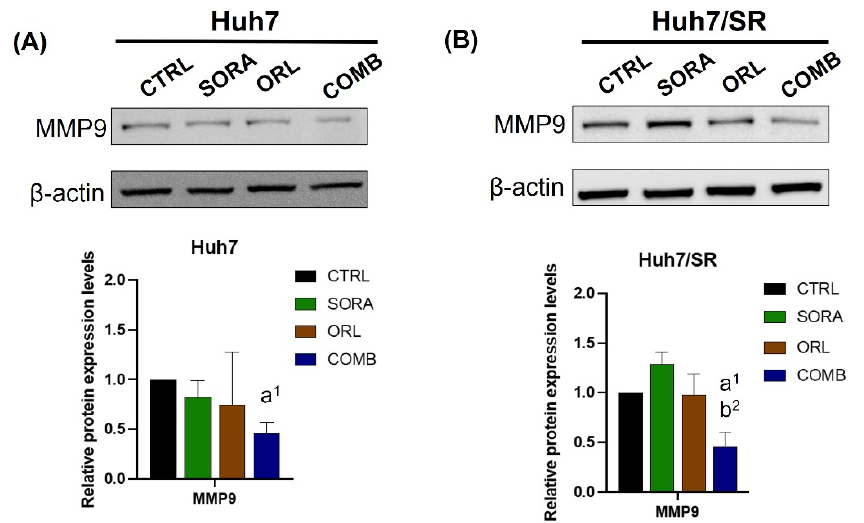
Figure 7. Combination treatment of sorafenib and orlistat repressed the MMP-9 expression in both ( A ) Huh7 and ( B ) Huh7/SR cells. Combination treatment suppressed MMP-9 level in both cell lines. a, compared to Control; b, compared to Sorafenib; 1 p < 0.05; 2 p < 0.01.